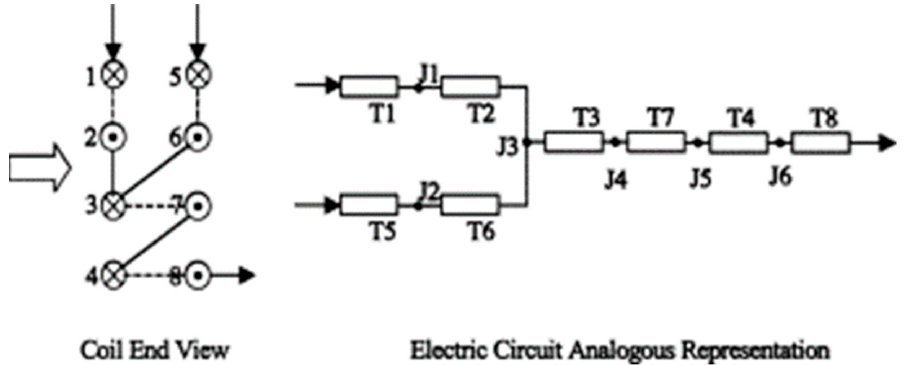
Figure 7. Electric network-like representation of tube connections [34]. Rectangles represents tubes, each dot is a junction.